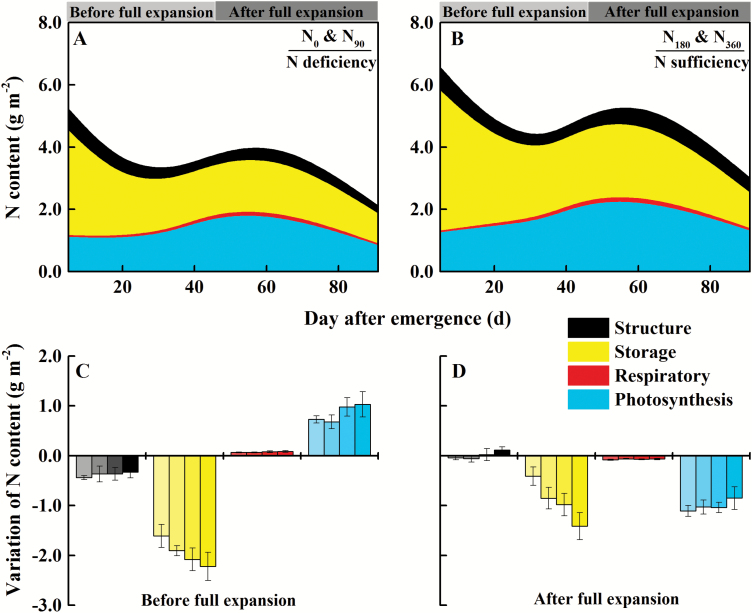
N partitioning by function of winter oilseed rape (Brassica napus L.) leaves along with the growth days of marked leaves under N deficiency (A) and N sufficiency (B). N0 and N90 treatments are classified as N deficiency; N180 and N360 treatments are classified as N sufficiency. The data in (A) and (B) are calculated by mean values of two N treatments, respectively. Variation of N partitioning by function of leaves (C) from emergence (S1) through full expansion (S4) and (D) from full expansion (S4) through senescence (S6) under different N supply. In the same group of histograms, the columns from left to right indicate the rates of N fertilizer application from low to high. Data are the mean of three repetitions per treatment and bars represent the SD. Leaf growth can be divided into two stages: before full expansion (S1–S3) and after full expansion (S4–S6).